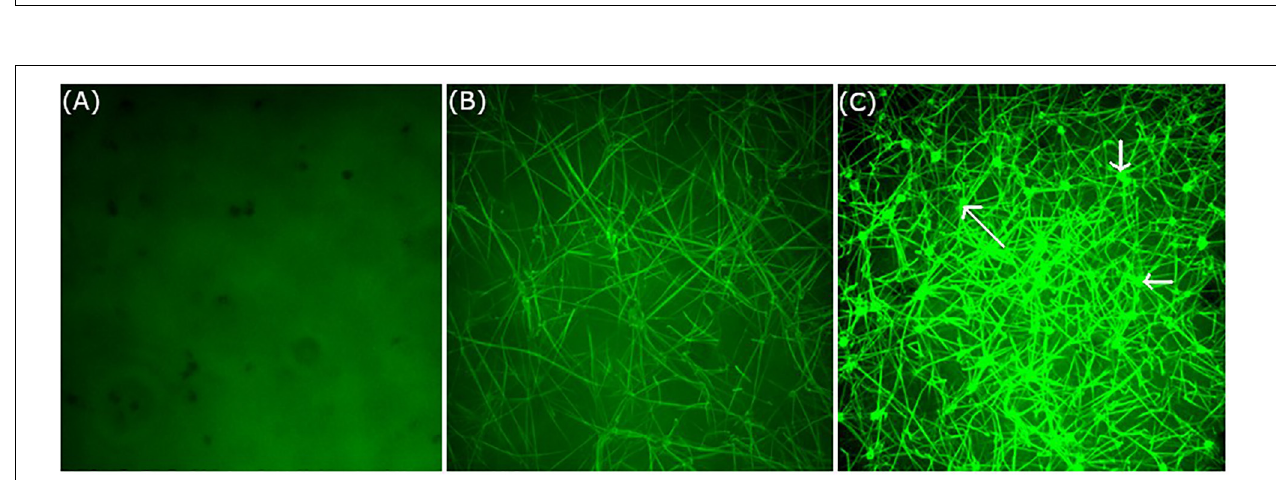
FIGURE 3 | Influence of temperature on coagulation and platelet function visualized with Real Time Live Confocal Imaging. Representative pictures of one healthy volunteer were chosen to visualize the fibrin net (green, iFXIIIa) at (A) 4 ◦ C, (B) 24 ◦ C, and (C) 37 ◦ C. Note the near absence of a fibrin network at 4 ◦ C and the highest density of the fibrin network under 37 ◦ C conditions as compared to the fibrin network formed at 24 ◦ C. This is also paralleled by platelet activity as shown in C (see arrows). Objective: 63 × oil immersion.